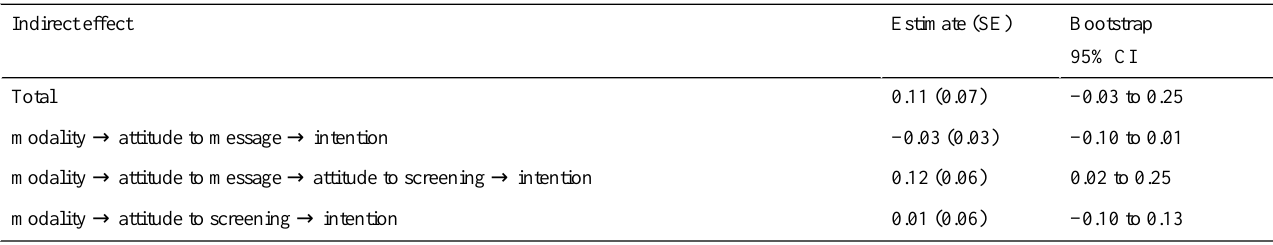
Table 4. Total and indirect effects for text modality on intention mediated by attitudes toward the message and attitudes toward the screening